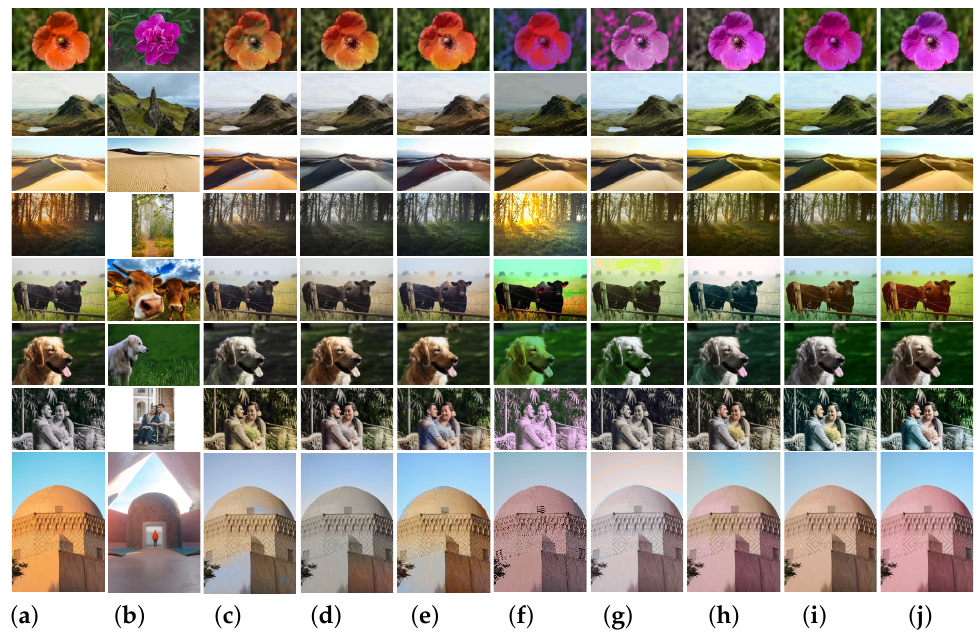
Figure 6. Comparison of coloring effects of different algorithms. The first column is the target image (TI), and the second column is the reference image(RI). ( a ) TI. ( b ) RI. ( c ) [4]. ( d ) [5]. ( e ) [6]. ( f ) [1]. ( g ) [9]. ( h ) [18]. ( i ) [47]. ( j )